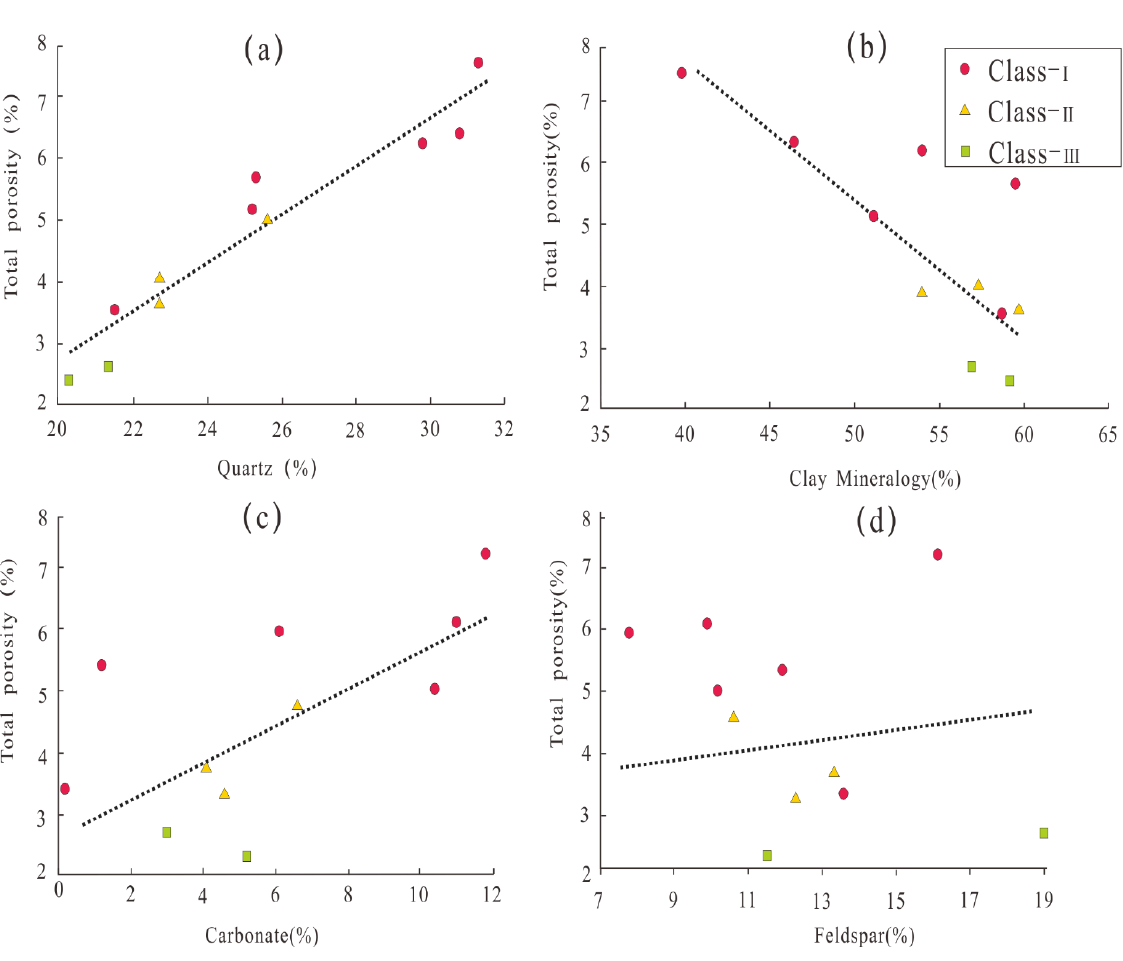
Figure 7. Relationships between mineral components and total porosity of shale samples from Da’an area, southern Songliao Basin ( a ) Relationship between quartz content and total porosity; ( b ) Relationship between clay mineral content and total porosity; ( c ) Relationship between carbonate mineral content and total porosity; ( d ) Relationship between feldspar content and total porosity.